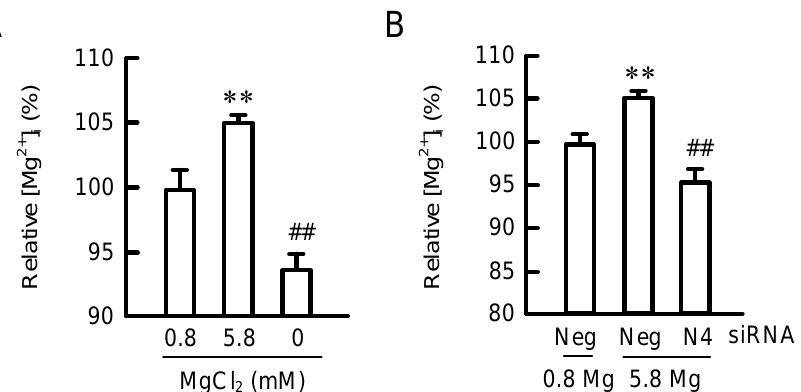
Figure 3. Effects of extracellular Mg 2+ concentration and NIPAL4 siRNA on [Mg 2+ ] i . ( A ) Cells were incubated in the presence of 0, 0.8, and 5.8 mM MgCl 2 for 24 h. The cells were loaded with KMG-20-AM for 30 min at 37 °C. The fluorescence intensity of KMG-20 was measured using a plate reader. [Mg 2+ ] i is represented as a percentage of 0.8 mM MgCl 2 . ( B ) Cells were transfected with negative (Neg) or NIPAL4 (N4) siRNA. After 48 h of transfection, the cells were incubated in the presence of 0.8 and 5.8 mM MgCl 2 for 24 h. [Mg 2+ ] i is represented as a percentage of 0.8 mM MgCl 2 . n = 4–6. ** p < 0.01 significantly different from 0.8 mM MgCl 2 . ## p < 0.01 significantly different from negative siRNA plus 5.8 mM MgCl 2 .